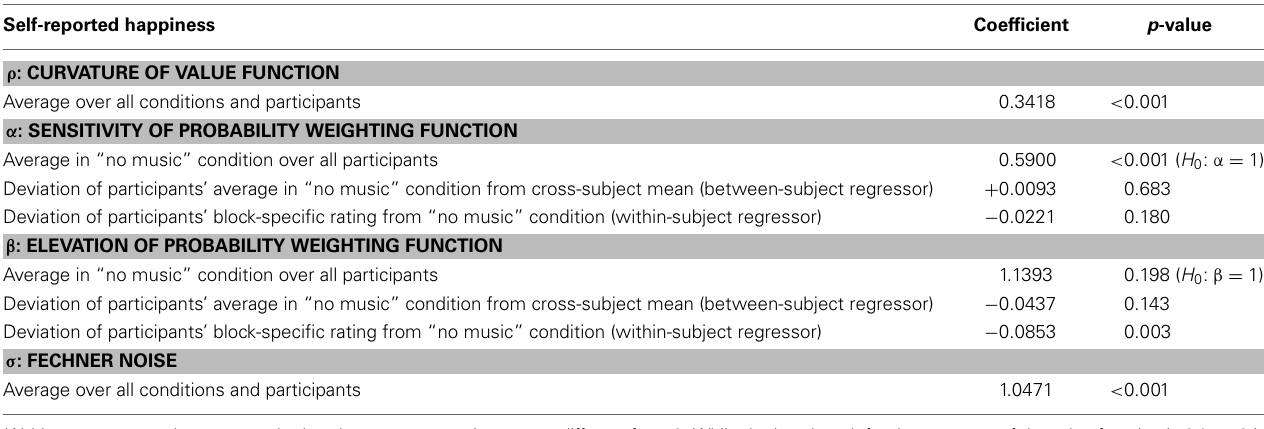
Table 3 | Structural regression model: estimates of preference parameters—sensitivity and elevation of the probability weighting function as functions of the between-subject and within-subject variation in self-reported happiness. Self-reported